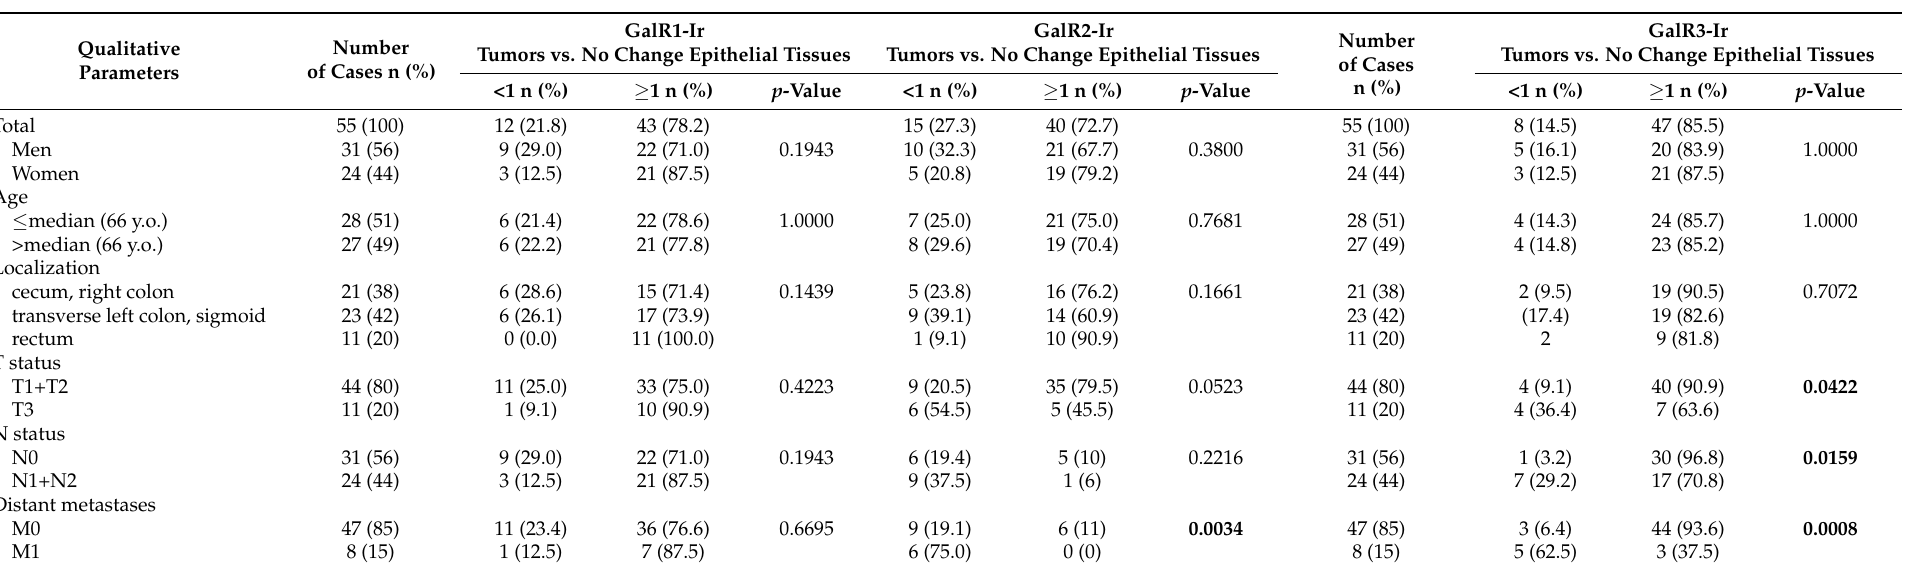
Table 1. Associations between demographic and clinical-pathological features of colorectal cancer (CRC) patients and relative protein expression determined by